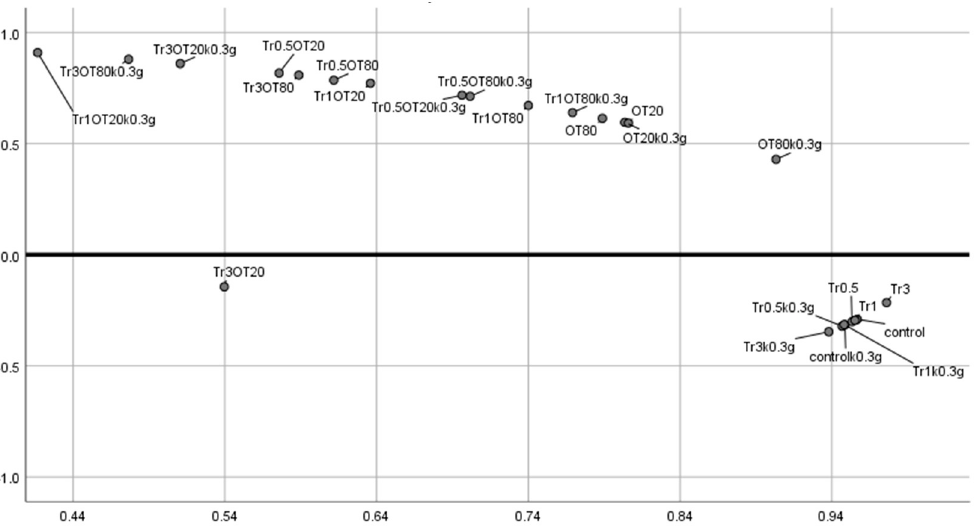
Figure 12. Overall PCA analysis.